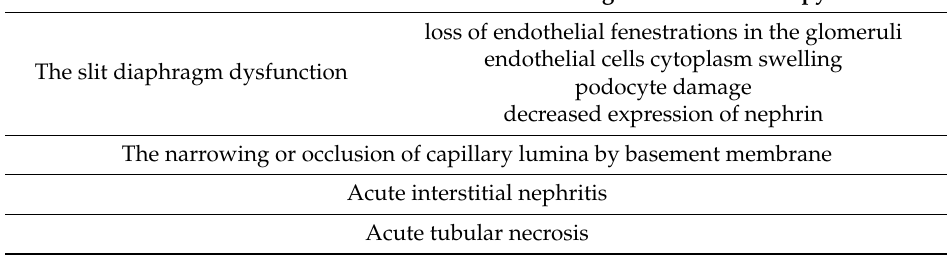
Table 4. The causes of proteinuria in patients receiving the vascular endothelial growth factor signaling pathway inhibitor (anti-VEGF)